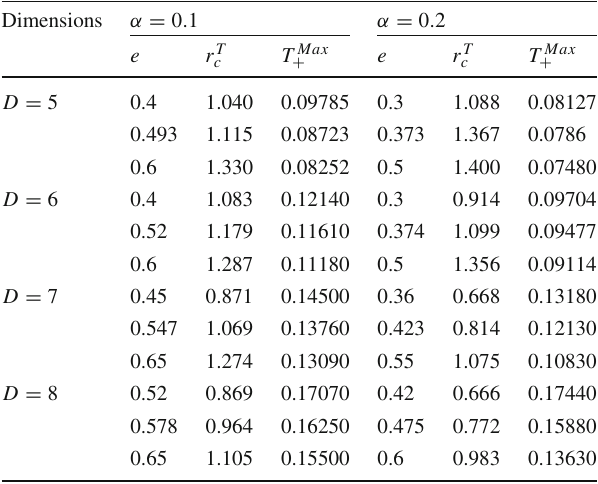
Table 2 The maximum Hawking temperature T Max + at critical radius r T for different values of charge e and different dimension D = 5 , 6 , 7 C and 8 with fixed value of l = 10